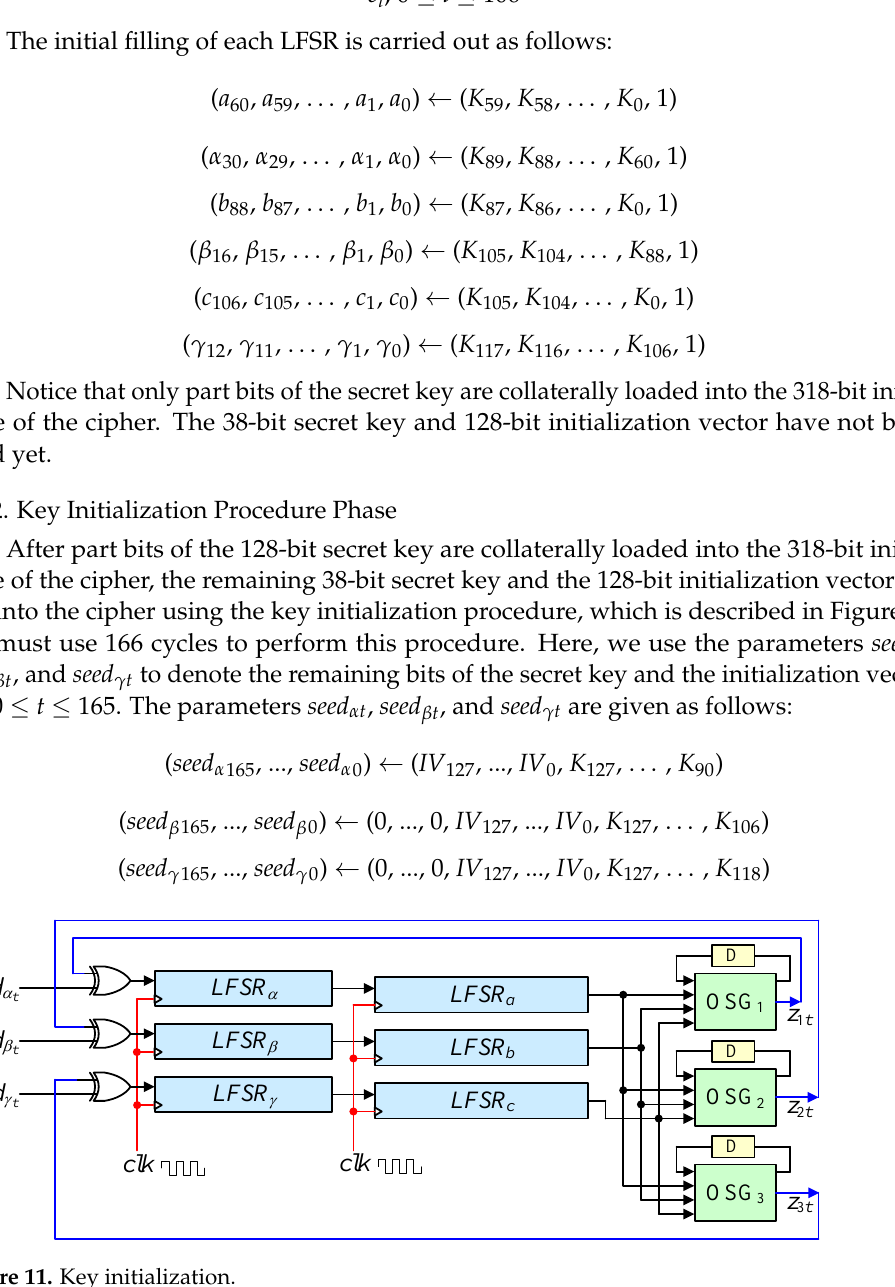
Figure 11. Key initialization.